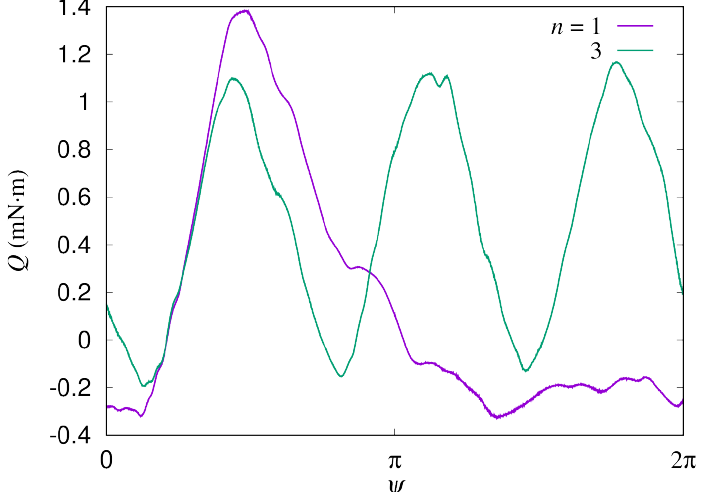
Figure A3. Torque dependence on the azimuthal angle obtained by CFD. Equation (6) tries to simulate this dependence.